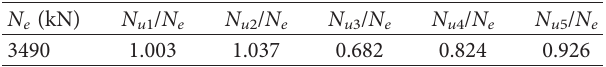
Figure 17: Effectively confined area of core concrete: (a) lateral section and (b) longitudinal section. Table 7: Axial bearing capacity of the